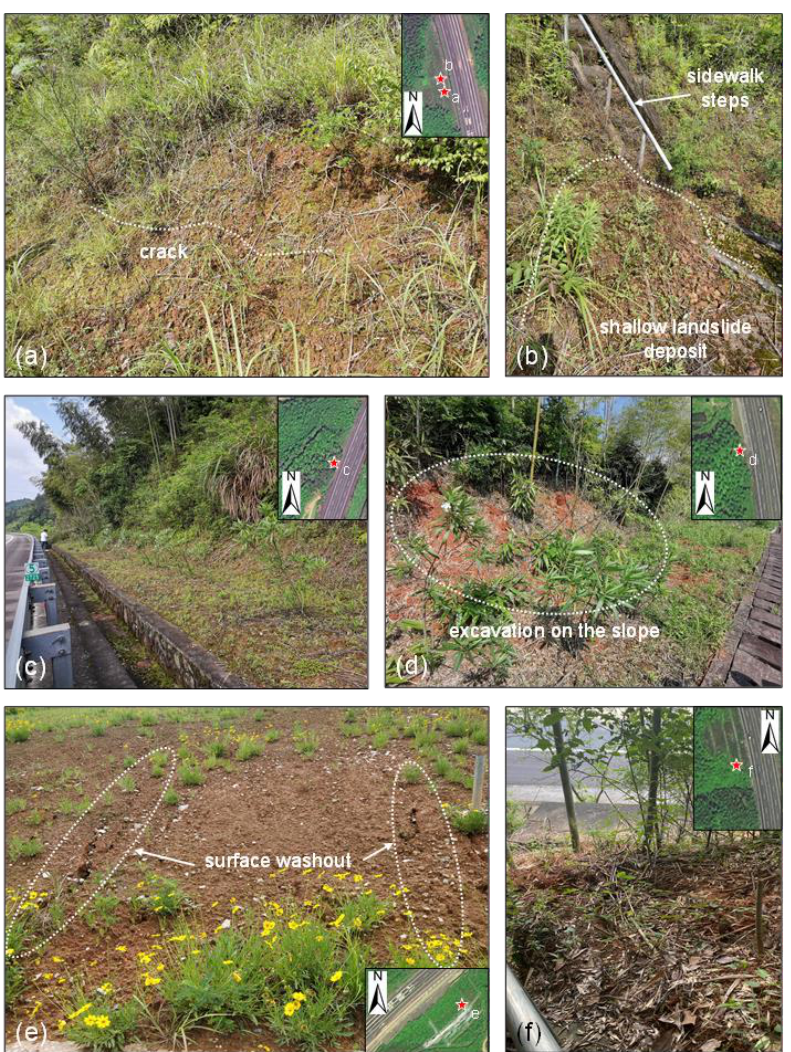
Figure 11. Field validation photographs of potential hazards P1~P5. ( a ) Joint crack at the 2nd-level slope. ( b ) Shallow landslide on top of the 2nd-level slope. ( c ) Full view of P2. ( d ) Excavation on the slope. ( e ) Slope surface washout. ( f ) Vegetation cover on slope.